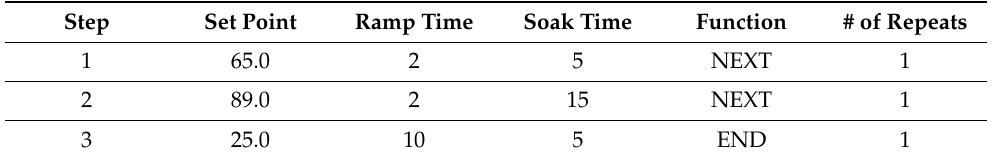
Table 5. The ‘set point’, ‘ramp time’, ‘soak time’, ‘function’, and ‘# of repeats’ inputs for post-exposure baking in Teca